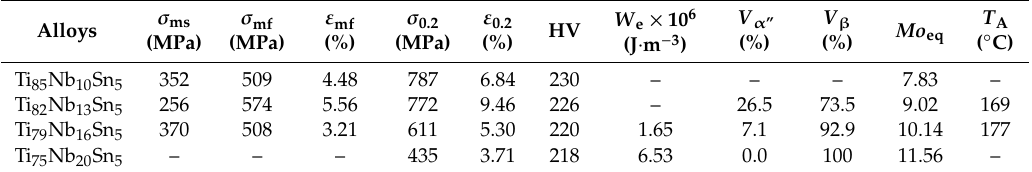
Table 1. Measured mechanical properties of various alloys, including the initial stress ( σ ms ), finished stress ( σ mf ), and finished strain ( ε mf ) of martensitic transformation, 0.2 % o ff set yield stress ( σ 0.2 ),